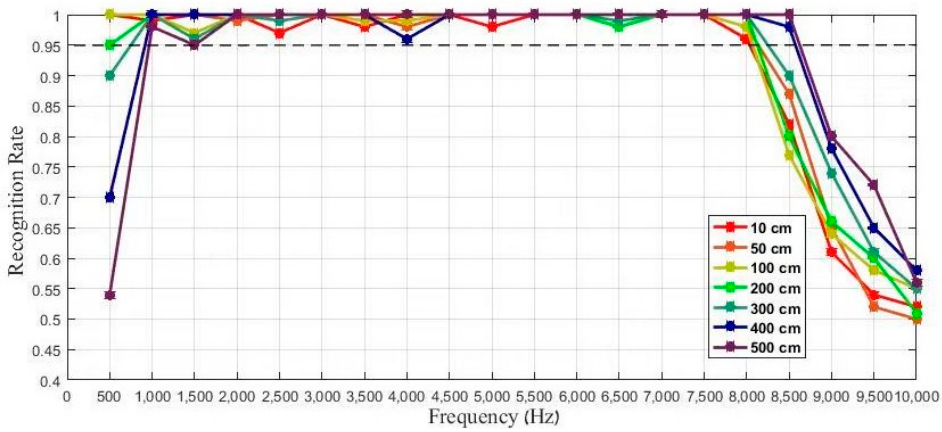
Figure 15. The recognition rate at different distances with different frequencies.